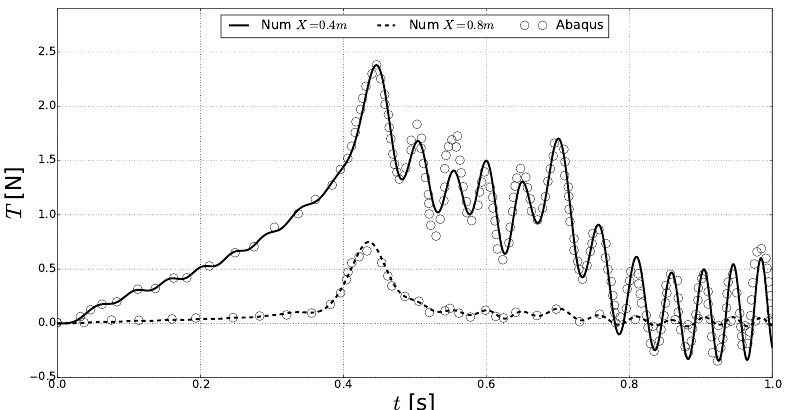
Figure 9. Tension force distribution over time at two different positions for the swinging elastic